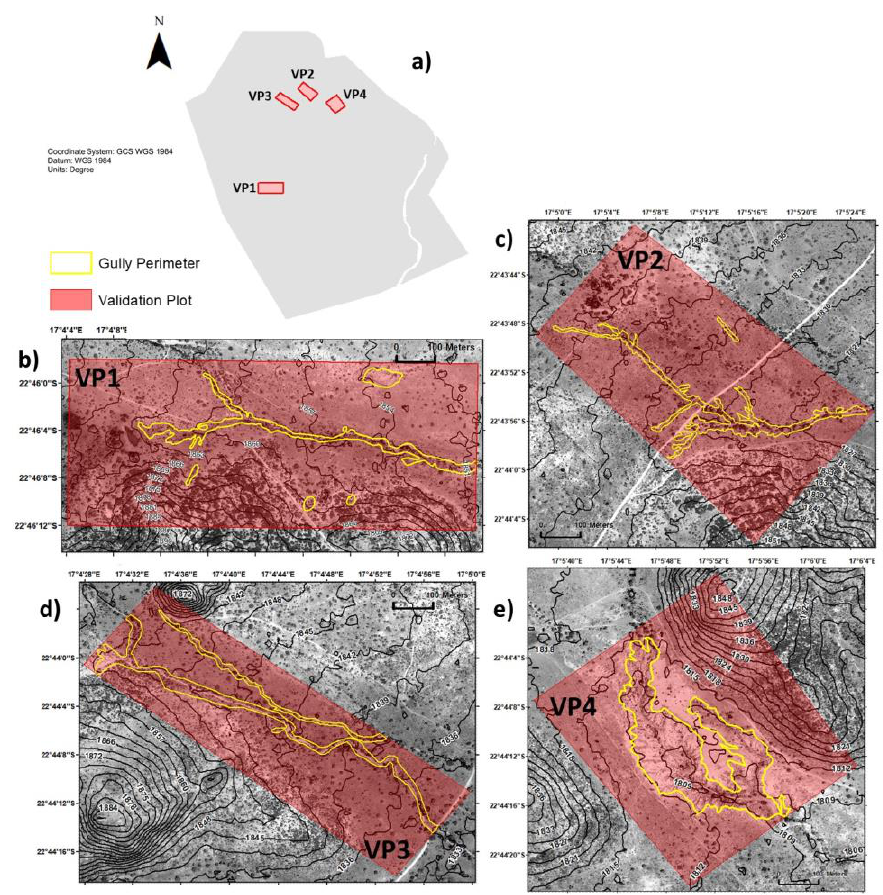
Figure 7. ( a ) Location map of the different study sites within Krumhuk Farm. ( b - e ) Background of Satellite image (Pleiades) and the different Validation Plots (VPs) (represented by red shadow) enclosing the gully networks (main and secondary gullies perimeters) under study outlined with yellow.